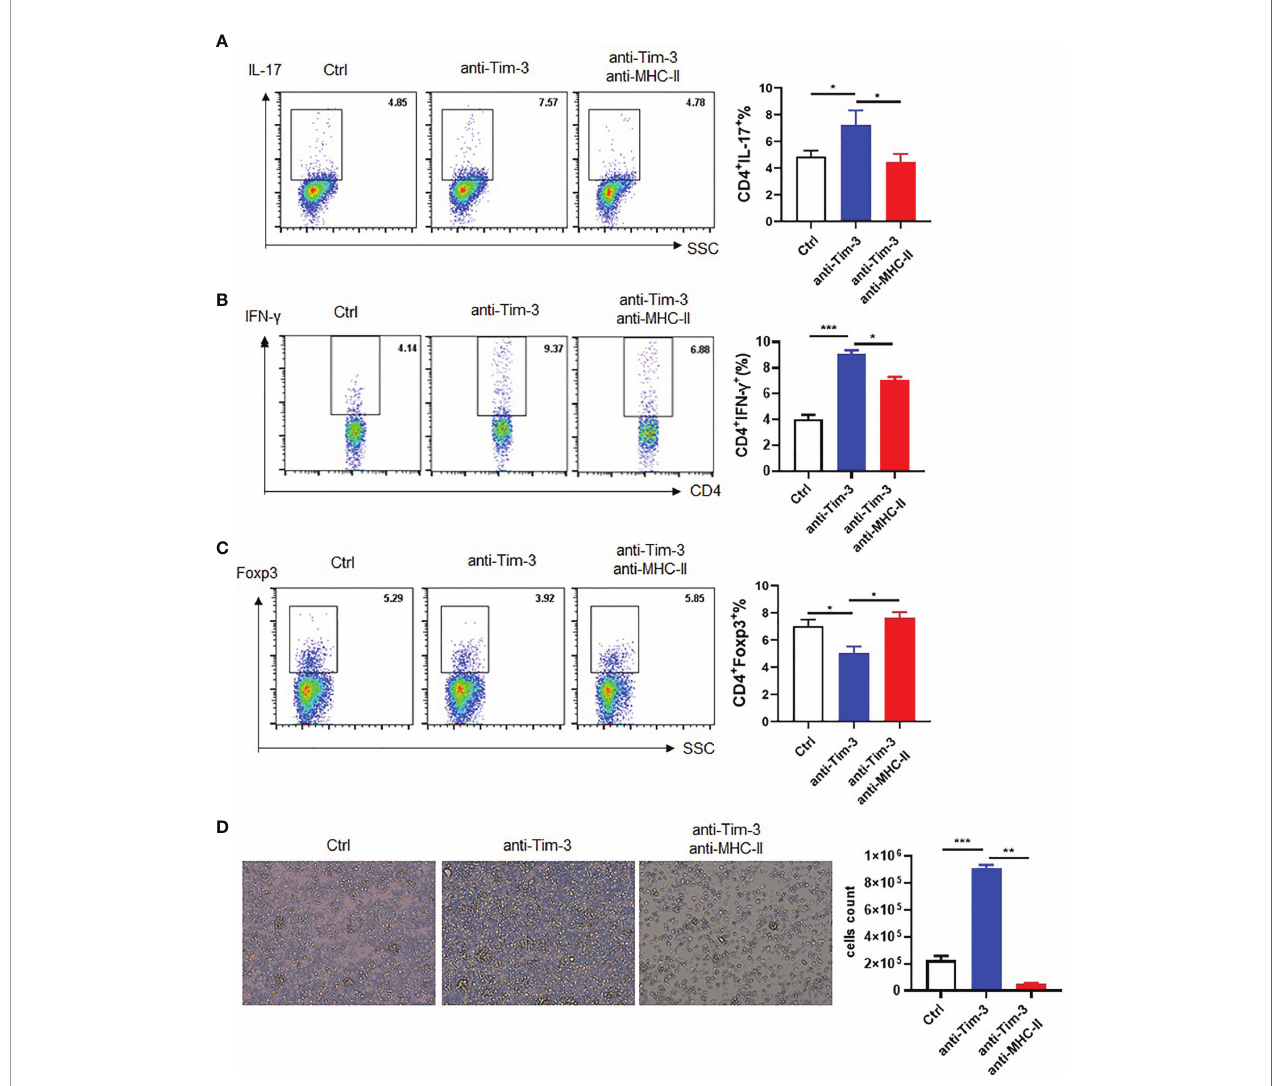
FIGURE 6 | Tim-3 inhibits macrophage MHC-II antigen presentation in vitro . Peritoneal macrophages were collected from WT mice, and anti-Tim-3 antibody (10 m g/ ml) was added to culture overnight then incubated with MOG (10 m g/ml) for 4 h. Moreover, they were incubated with or without anti-MHC-II antibody (10 m g/ml) for 30 min, and then splenic lymphocytes were added to coculture for 24 h. The splenic lymphocyte suspension was collected to detect the ratio of (A) IL-17 + CD4 + T (mean ± SD, n = 4), (B) IFN- g + CD4 + T (mean ± SD, n = 4), and (C) Foxp3 + CD4 + T cells by fl ow cytometry (mean ± SD, n = 3). (D) Splenic lymphocytes of WT mice were cocultured for 3 days and photographed with a microscope, and then spleen cells were for collected for counting (mean ± SD, n = 3) (*p < 0.05; ***p <